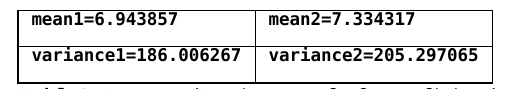
Table 2. Means and Variance results from splitting data